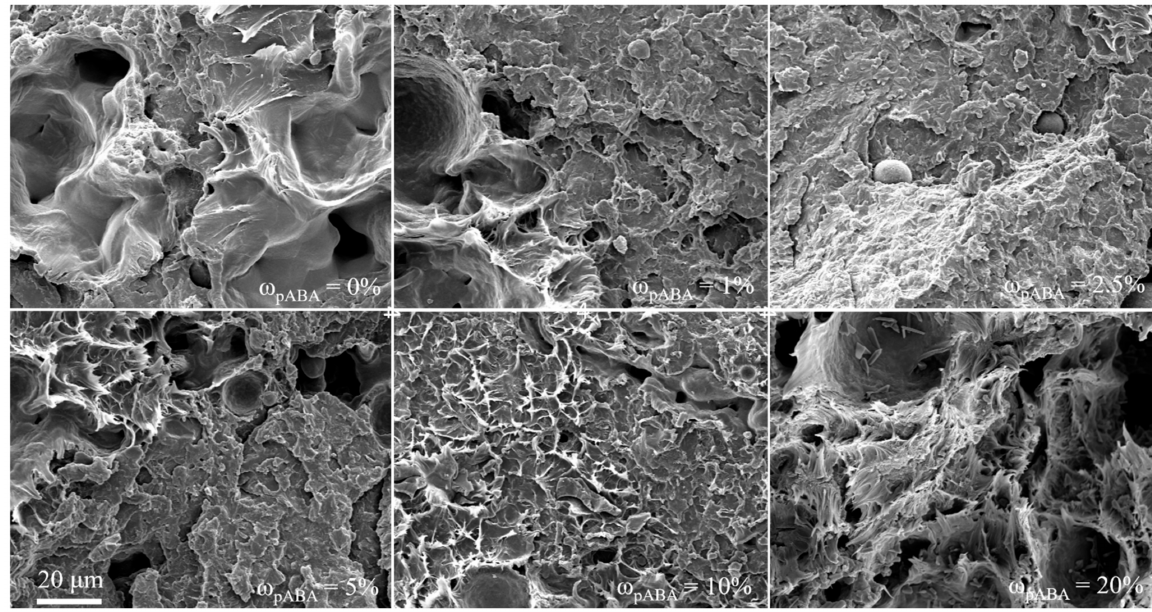
Figure 11. Scanning electron micrographs of fracture surfaces depending on the fraction of